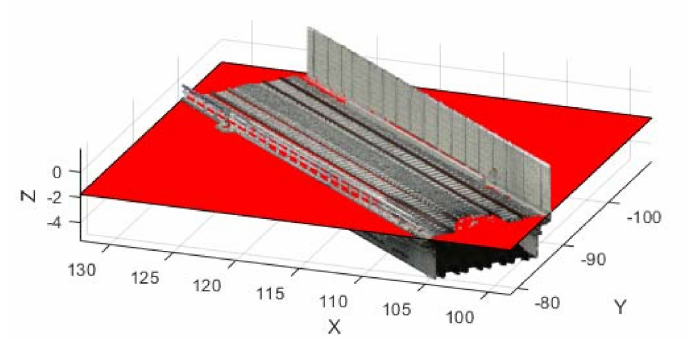
Figure 23. Plane prediction for the Osong test track fifth bridge using the